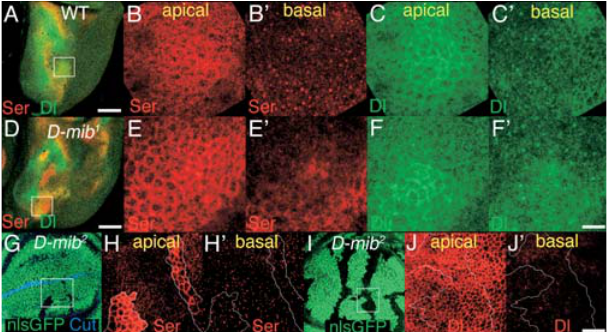
Figure 4. D-mib Is Required to Down-Regulate Ser at the Apical Cortex (A–F 9 ) Distribution of Dl (green) and Ser (red) in the notum region of wild-type (A–C 9 ) and D-mib 1 mutant (D–F 9 ) wing imaginal discs. The boxed areas in (A) and (D) are shown at higher magnification in (B– F 9 ). The specific loss of Ser accumulation into intracellular vesicles (compare [E 9 ] with [B 9 ]) correlated with the elevated levels of Ser seen at the apical cortex of D-mib mutant cells (compare [E] with [B]). (G–J 9 ) Ser (red in [H and H 9 ]) accumulated at the apical cortex (H) as well as in intracellular dots (H 9 ) in D-mib 2 mutant cells (marked by the loss of nuclear GFP; green in [G]). Cut is shown in blue (G). The distribution of Dl (red in [J and J 9 ]) was not affected by the loss of D- mib activity. Low-magnification views of the wing portion of the discs are shown in (G) and (I). (H and H 9 ) and (J and J 9 ) show high magnification views of the areas boxed in (G) and (I), respectively. Clone boundaries are outlined in (H and H 9 ) and (J and J 9 ).